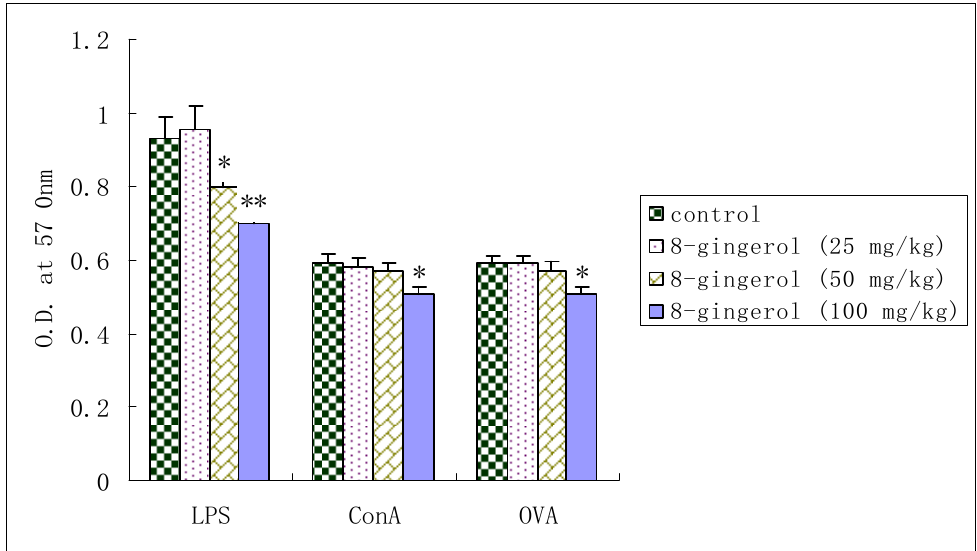
Figure 4. Effect of 8-gingerol on splenocyte proliferation in OVA- immunized mice.